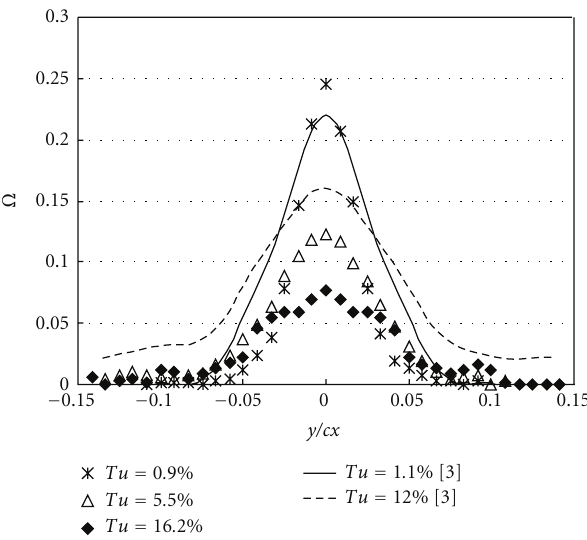
Figure 4: Comparisons of total pressure loss coe ffi cients for symmetric airfoils [5], with ones from Ames and Plesniak [3] for smooth airfoils ( k s /cx =